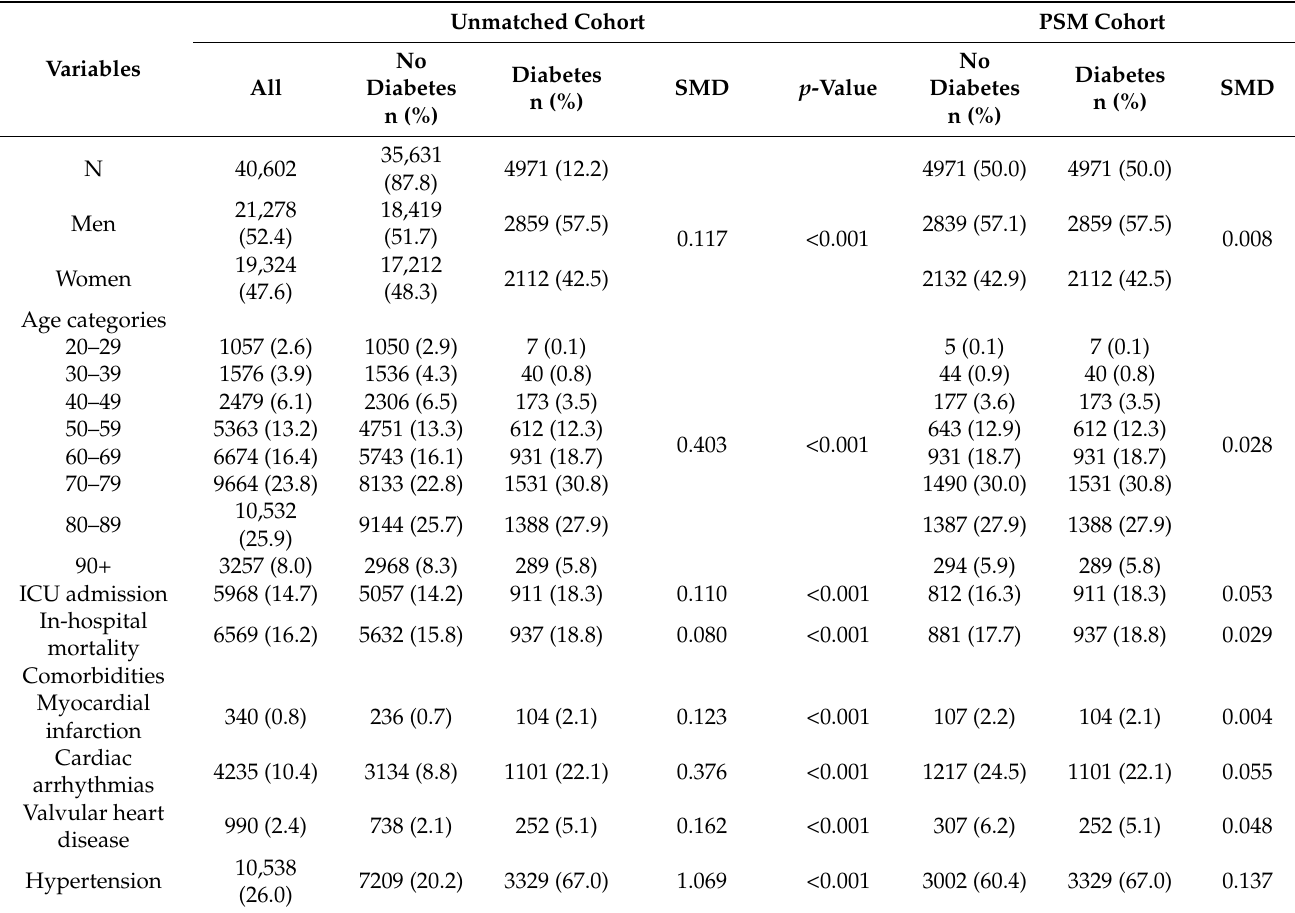
Table 1. Characteristics and comorbidities of diabetes and non-diabetes patients hospitalized for COVID-19 patients in unmatched and propensity score matched